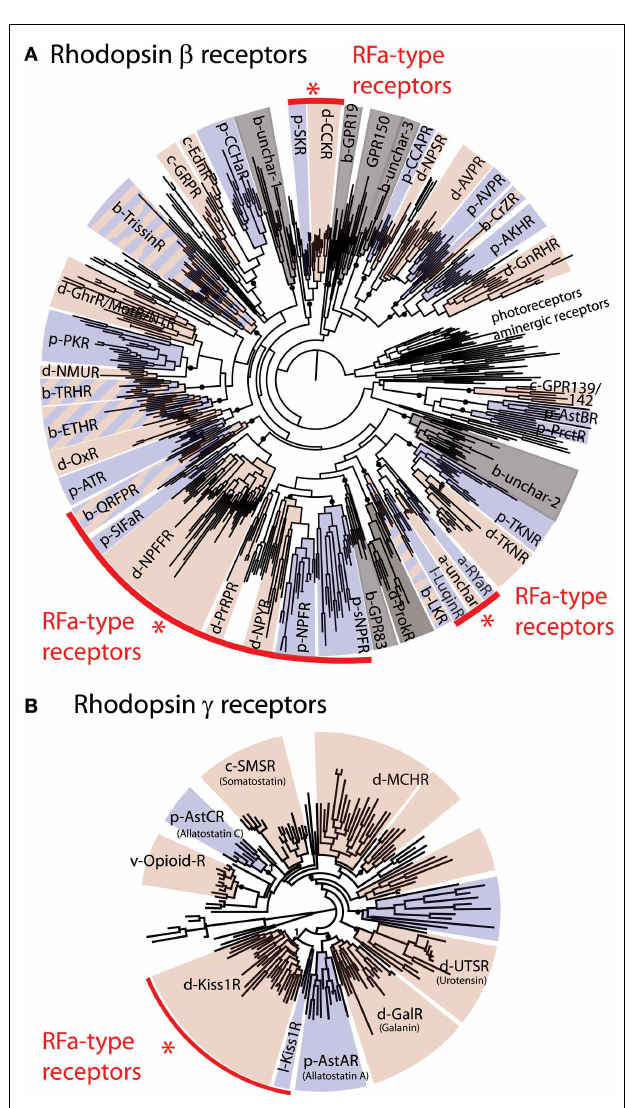
FIGURE 1 | Phylogenetic analysis of bilaterian rhodopsin β -type (A) and rhodopsin γ -type (B) receptors .The red arcs highlight four groups that include receptors that are known to be activated by RFamide-type peptides. These include a large group of receptors for QRFP (pyroglutamylated RFamide peptide), SIFa (SIFamide), NPFF (Neuropeptide FF and Gonadotropin-inhibitory hormone), PrRP (Prolactin-releasing peptide), NPY/NPF (NeuropeptideY/F), sNPF (short Neuropeptide F), and Luqin, and two isolated groups of RFamide-type receptors, CCK/SK (Cholecystokinin/Sulfakinin), and Kiss1 (Kisspeptin) receptors. In (A) rhodopsin α -type receptors (photoreceptors and aminergic receptors) are included as an outgroup.The prefixes b-, d-, p- designate subgroups of, respectively, bilaterian, deuterostomian, and protostomian receptors. Deuterostomian and protostomian clades have been colored in pink and blue, respectively. Gray sections of the trees correspond to groups of receptors for which either only deuterostomian or protostomian ligands are known.The fact that most of the rhodopsin β -type RFamide receptors fall in the same region of the tree suggests that these probably originated from a common ancestral RFamide-type neuropeptide signaling system. However, the occurrence of other groups of receptors that are activated by RFamides (CCK, Kiss1) indicates that RFamide-type neuropeptides have evolved independently at least three times in bilaterian history. Figure adapted from Ref.